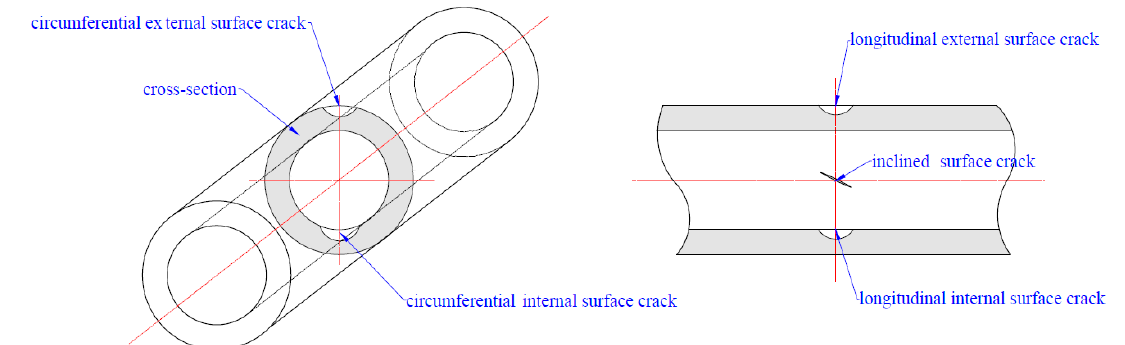
Figure 4. Research status of surface crack growth in different structures.